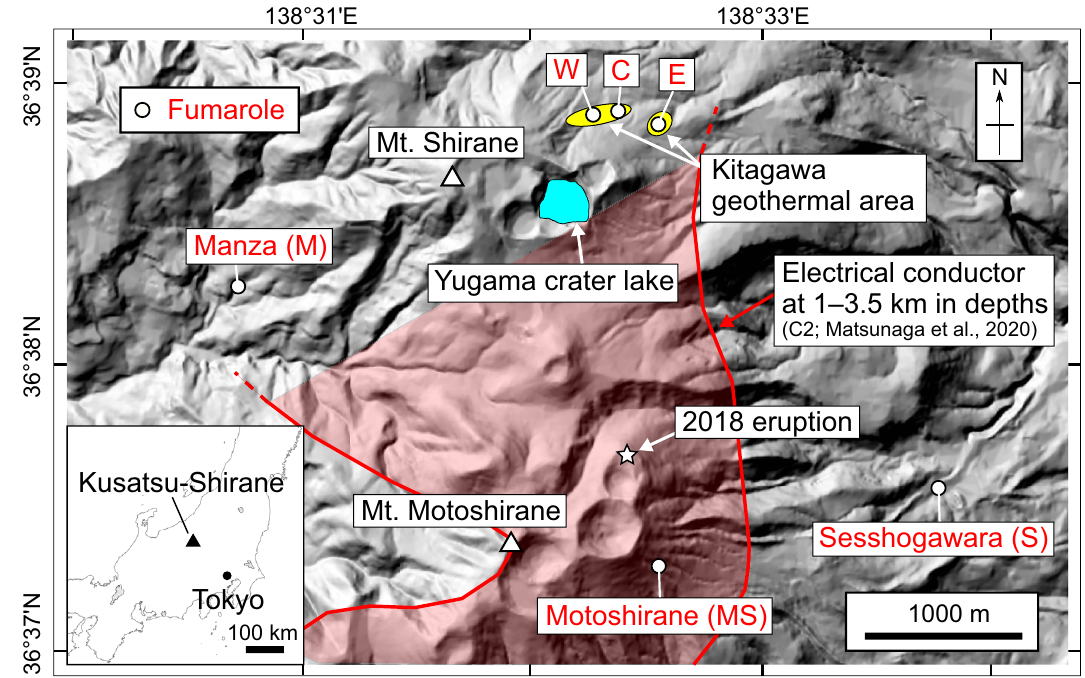
Figure 1. Map of the Kusatsu-Shirane volcano. White circles are the locations of fumaroles where samples were collected for this study. A white star indicates the location of the phreatic eruption on 23 January 2018. Yellow circles show the Kitagawa geothermal area located on the northern flank of Mt. Shirane. The red area indicates the horizontal extent of electrical conductor “C2”, which is probably a hydrothermal fluid reservoir beneath the Kusatsu-Shirane volcano 23 . The base map is from the website of the Geospatial Information Authority of Japan (https:// maps. gsi. go.